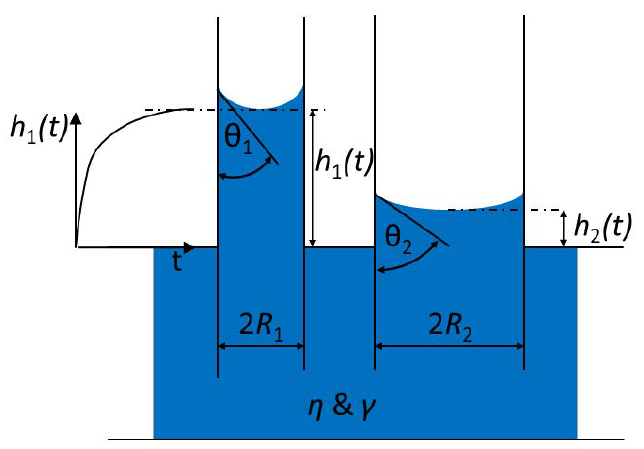
Figure 1. Schematic representation of the capillary rise of a fluid into a capillary showing the variables of the Washburn equation: the penetration depth h ( t ) , the infiltration time t , the pore radius R , the surface tension γ , the dynamic viscosity η of the fluid, and the contact angle θ between the fluid and the solid (modified from